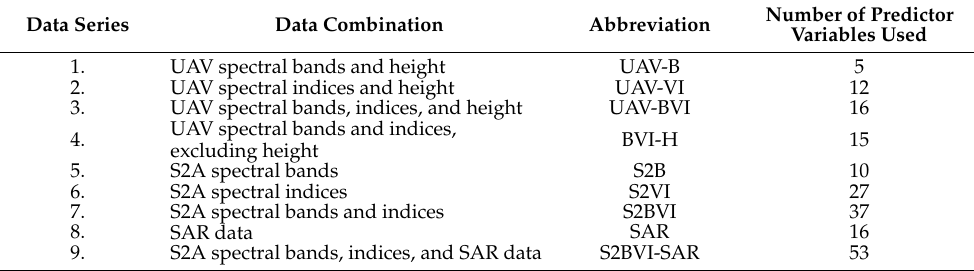
Table 3. List of parameters used for the image